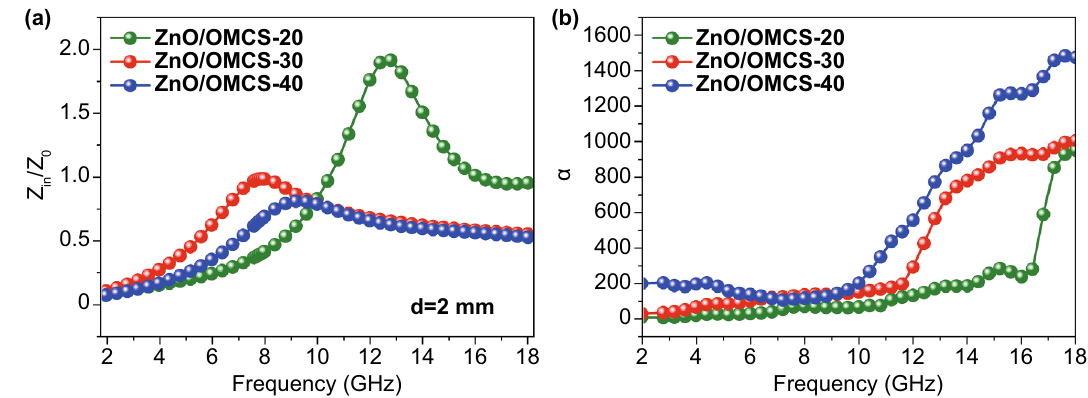
Fig. 7 a Relative input impedance of ZnO/OMCS-20, ZnO/OMCS-30, ZnO/OMCS-40 at 2 mm. b Attenuation constant of ZnO/OMCS-20, ZnO/OMCS-30, ZnO/OMCS-40